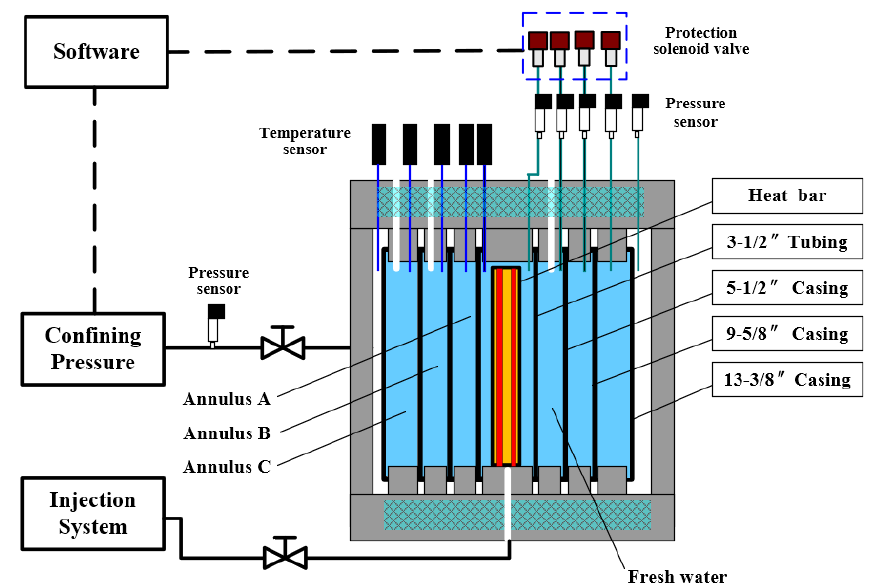
Figure 3. The schematic of the experimental setup.